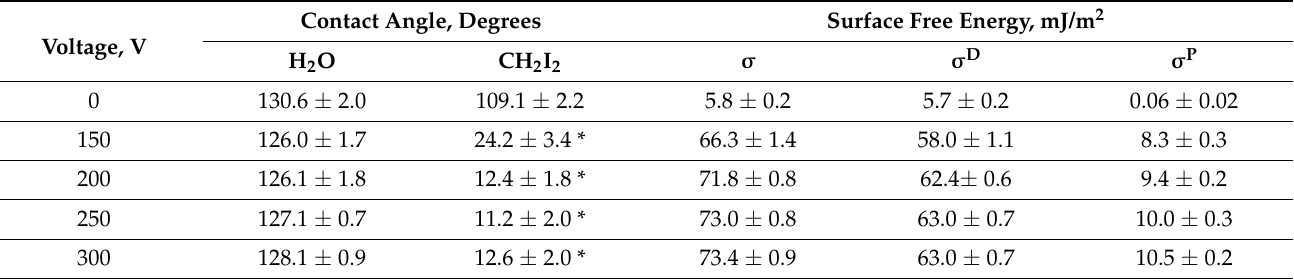
Table 3. Contact angles and free surface energy of the membranes with DLC coatings deposited under various parameters. Contact Angle, Degrees Surface Free Energy, mJ/m 2 Voltage, V H 2 O CH 2 I 2 σ σ D σ P